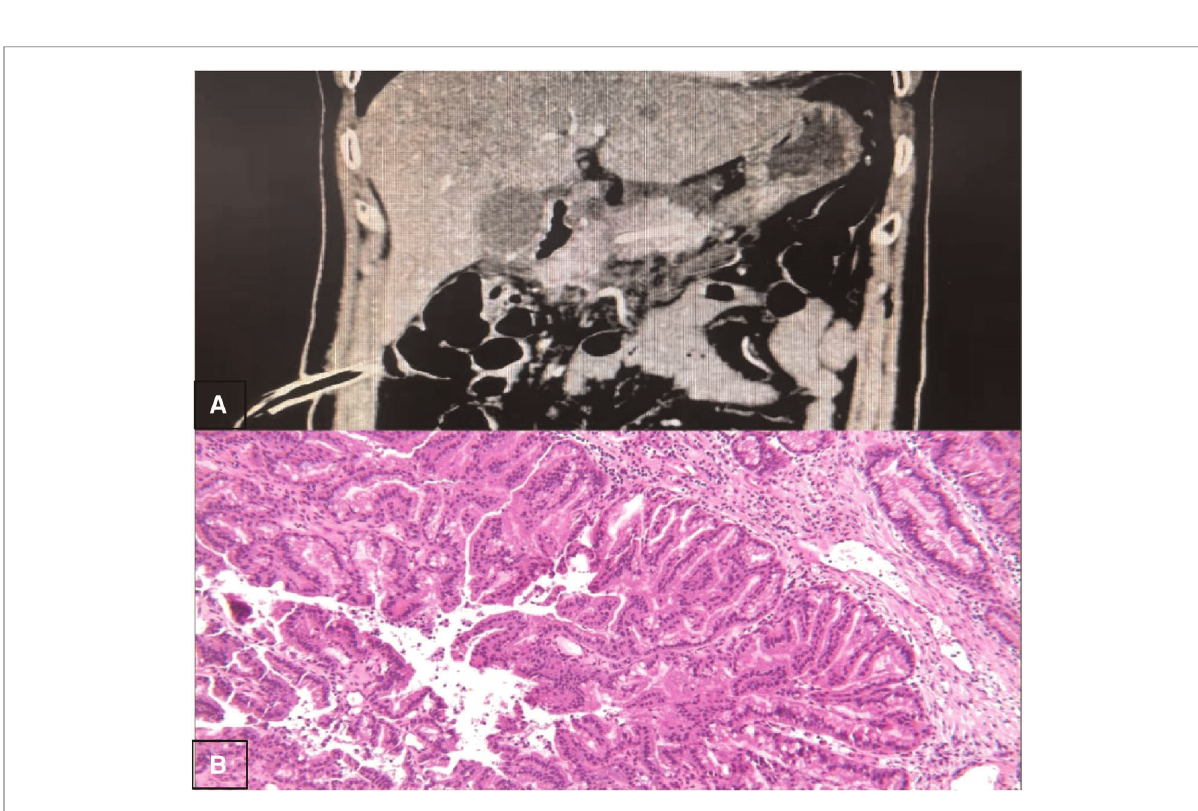
FIGURE 6 Postoperative outcome: CT and pathological images. A : CT images, B : pathological